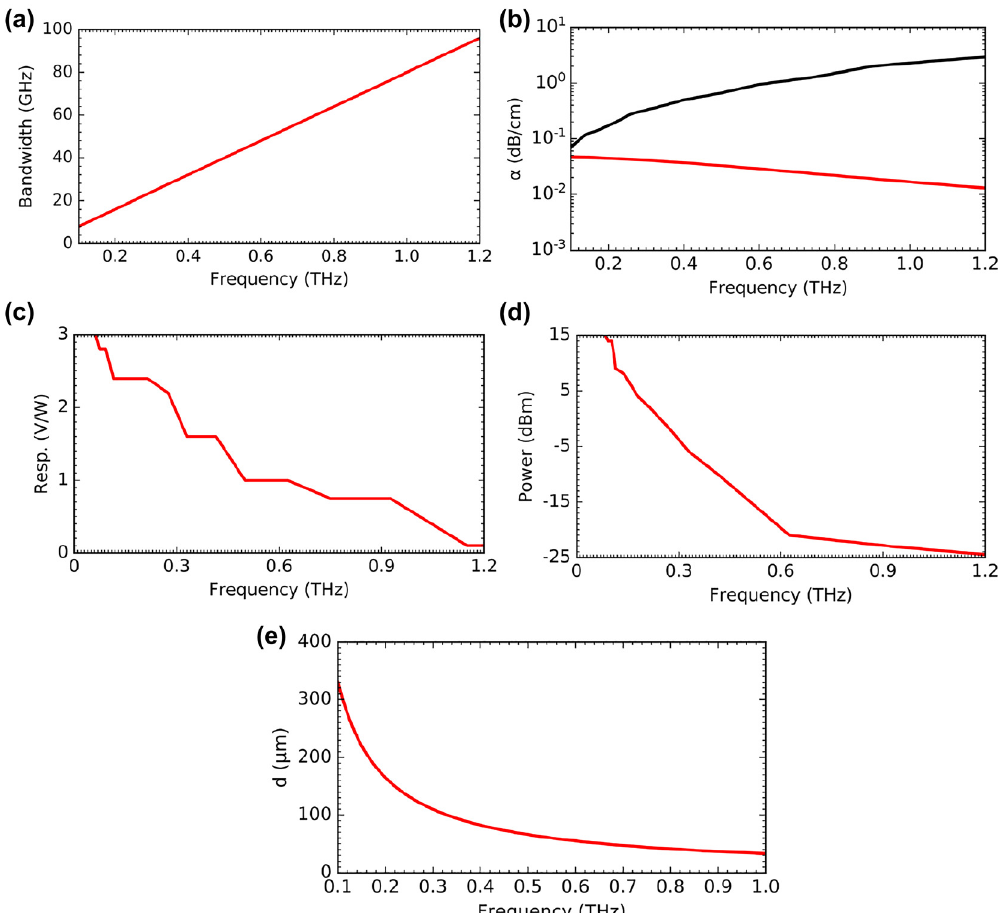
Figure 10: Advantages and challenges for the 1 THz band, (a) absolute bandwidth as a function of the frequency for the unclad waveguide, (b) attenuation as a function of the frequency of high resistivity silicon (red) and metal (black), (c) resp. of ZBD, (d) output power of signal generator and (e) hole diameter of Unclad waveguide as a function of